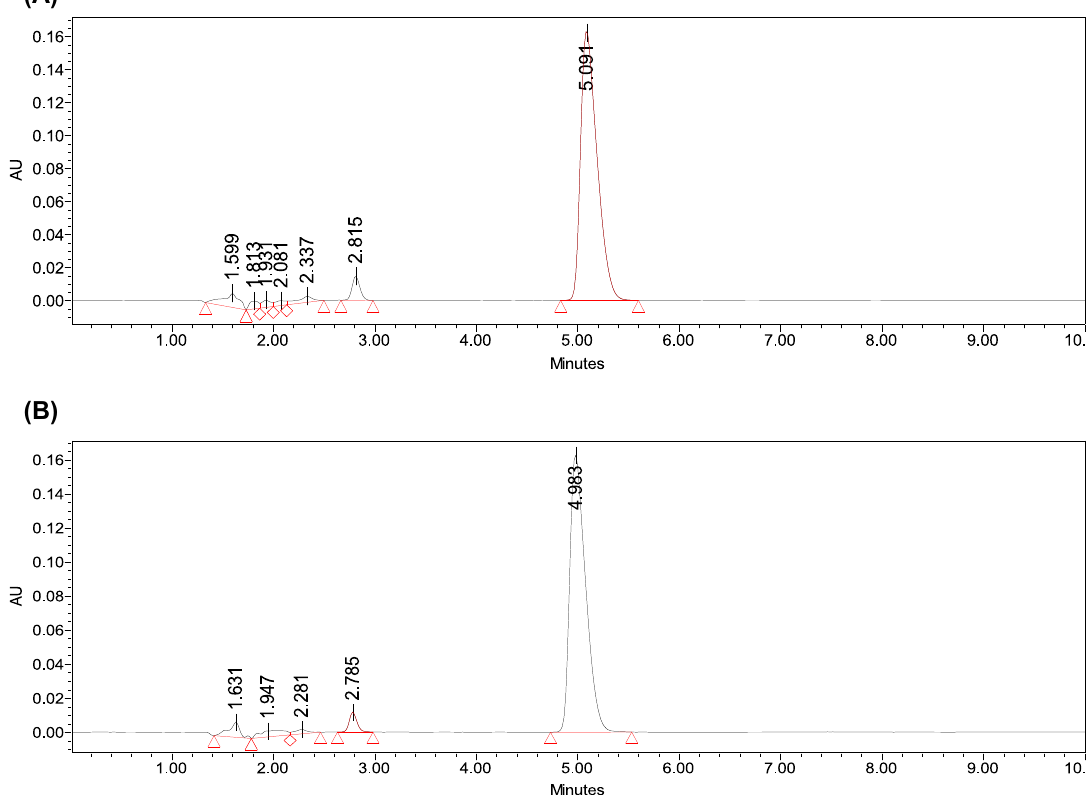
Figure 6: Representative HPLC-UV chromatograms of the compounded oral suspension at D0 (A) and D90